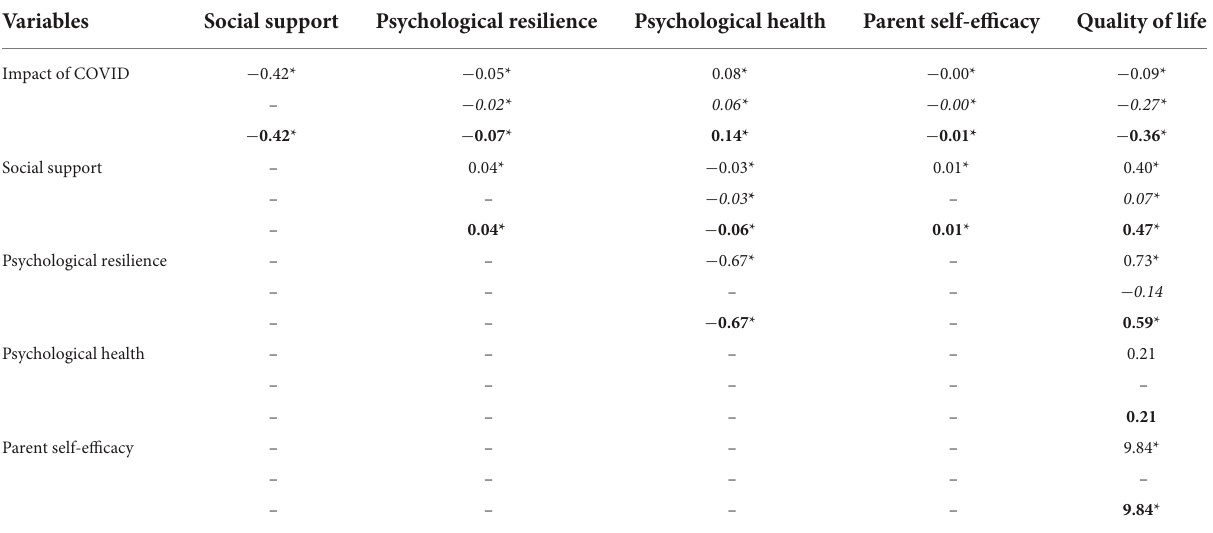
TABLE 6 Bootstrapped coefficients of total, direct, and indirect effects on endogenous variables in the final path